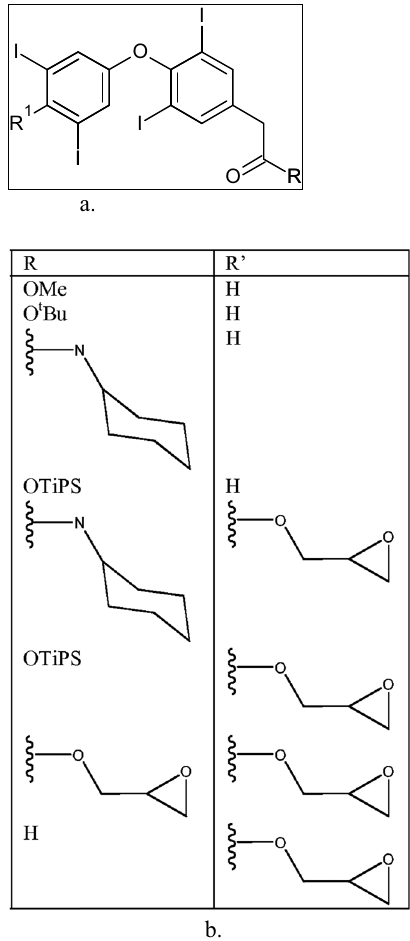
Figure 5: Thyroid hormone compounds, its analogs, and thyrointe - grin antagonist; ( a ) T3, ( b ) T4, ( c ) Triac, and ( d ) Tetrac.